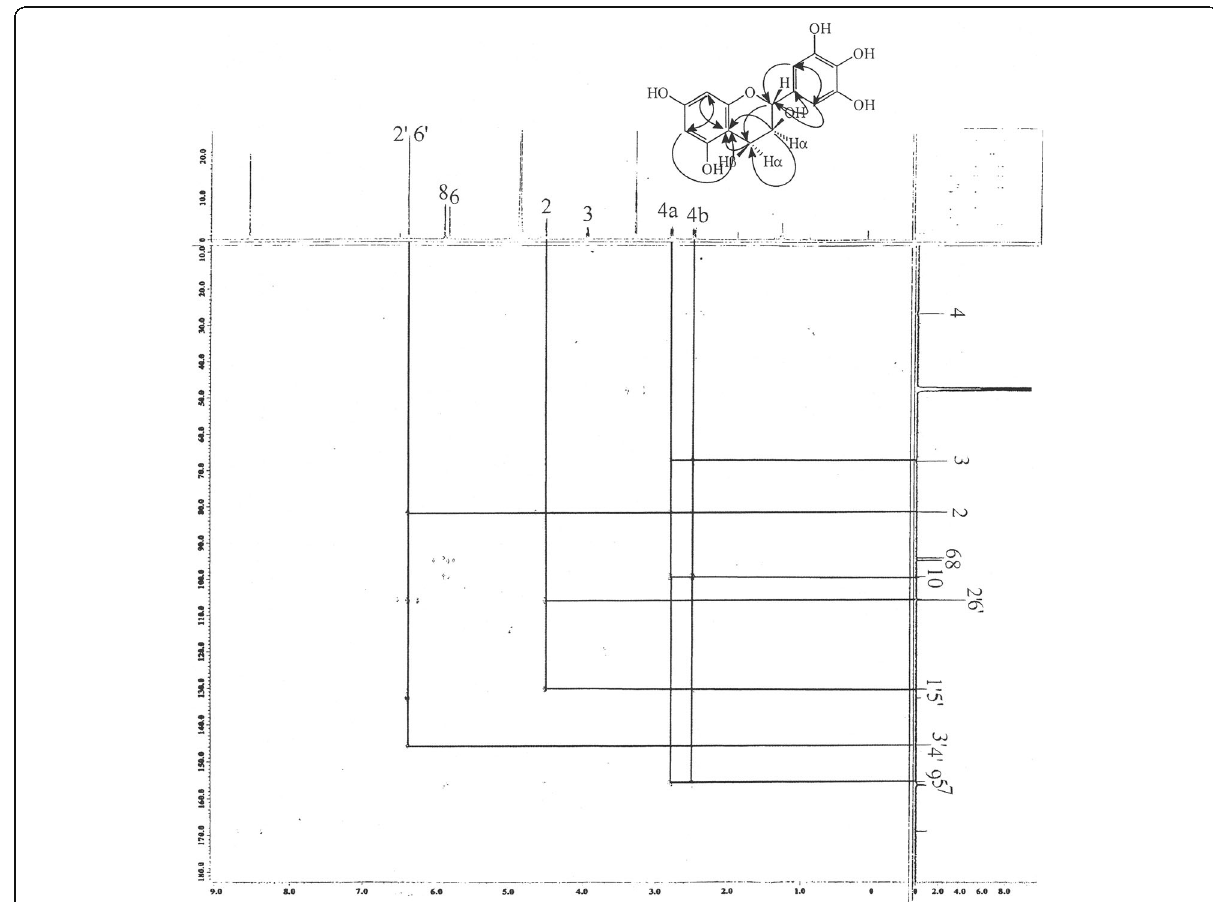
Fig. 2 HMBC spectrums of ( −